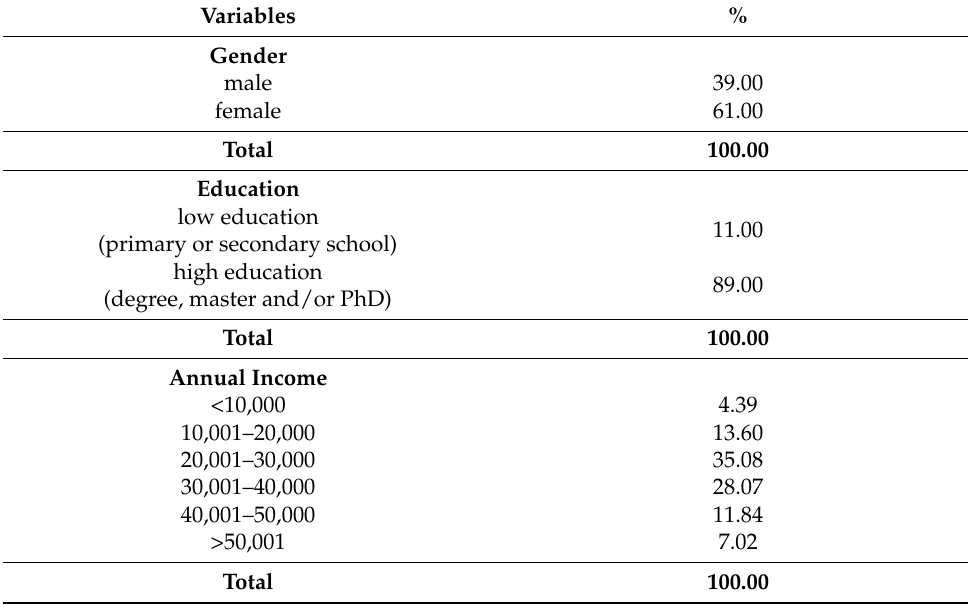
Table 3. Socioeconomic characteristics of the sample (N =